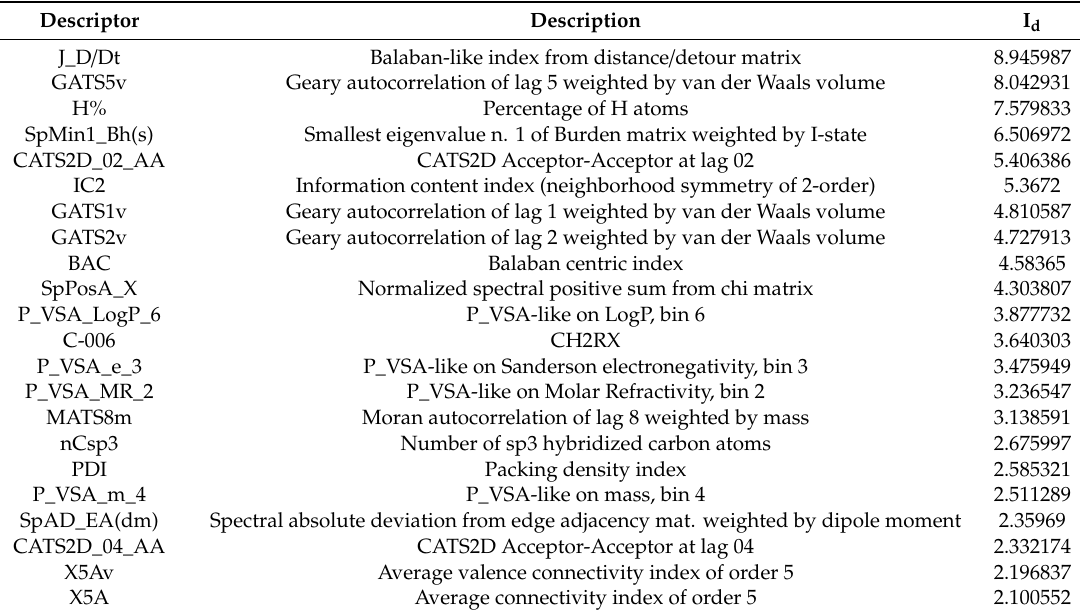
Table 5. Most important descriptors for models using the first modeling